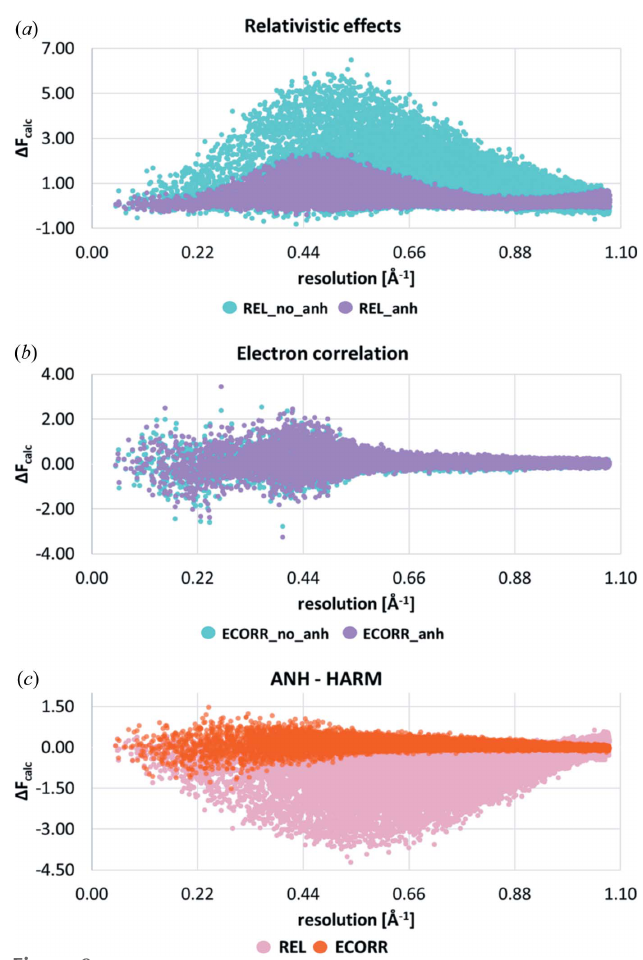
Figure 9 Differences in dynamic structure factors showing the effects of refinement of anharmonic thermal motion of Au ADP on the distribution of differences in the calculated dynamic structure factor amplitudes due to relativistic effects and electron correlation. On the x axis, sin (cid:4) / (cid:2) (A˚ (cid:5) 1 ) is plotted up to the maximum experimental resolution. On the y axis, the difference in calculated structure factors is plotted in absolute scale ( (cid:2) F calc